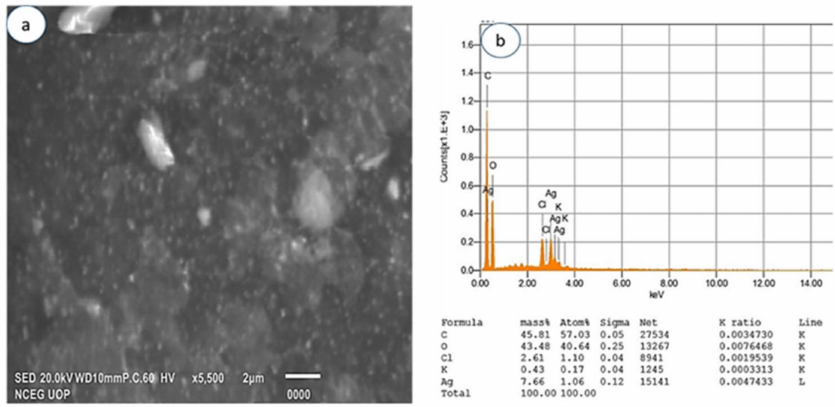
Figure 6. ( a ) SEM images and ( b ) EDX spectra of AgCS prepared from L. lucidum